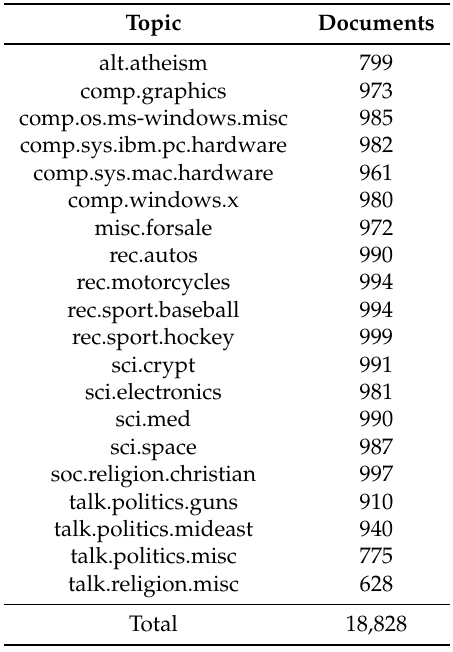
Table 1. Number of documents for each category in 20 Newsgroups